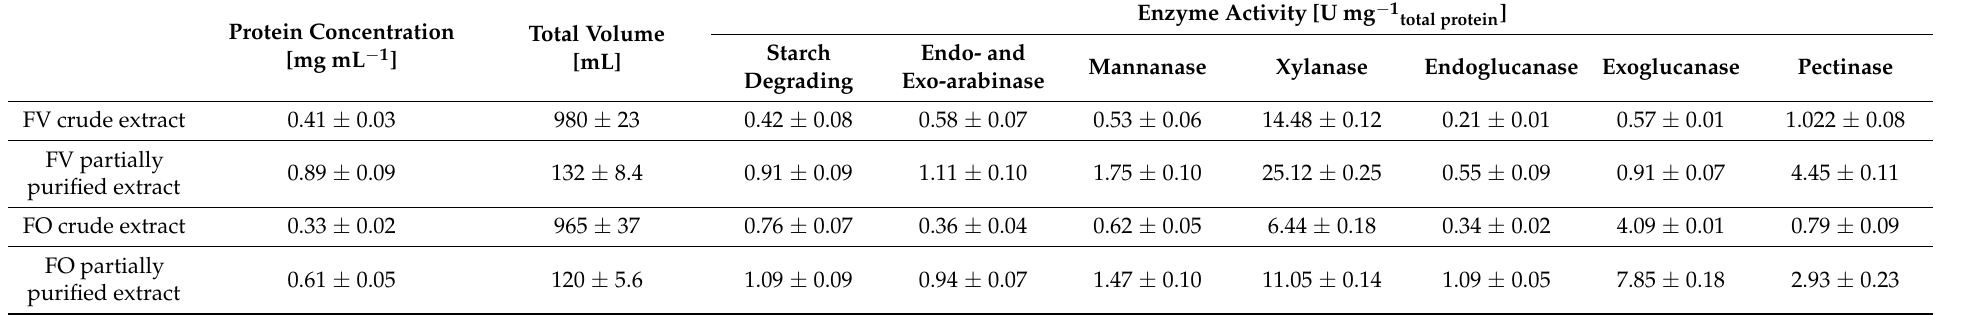
Table 3. Enzyme activities of crude and partially purified extracts of Fusarium